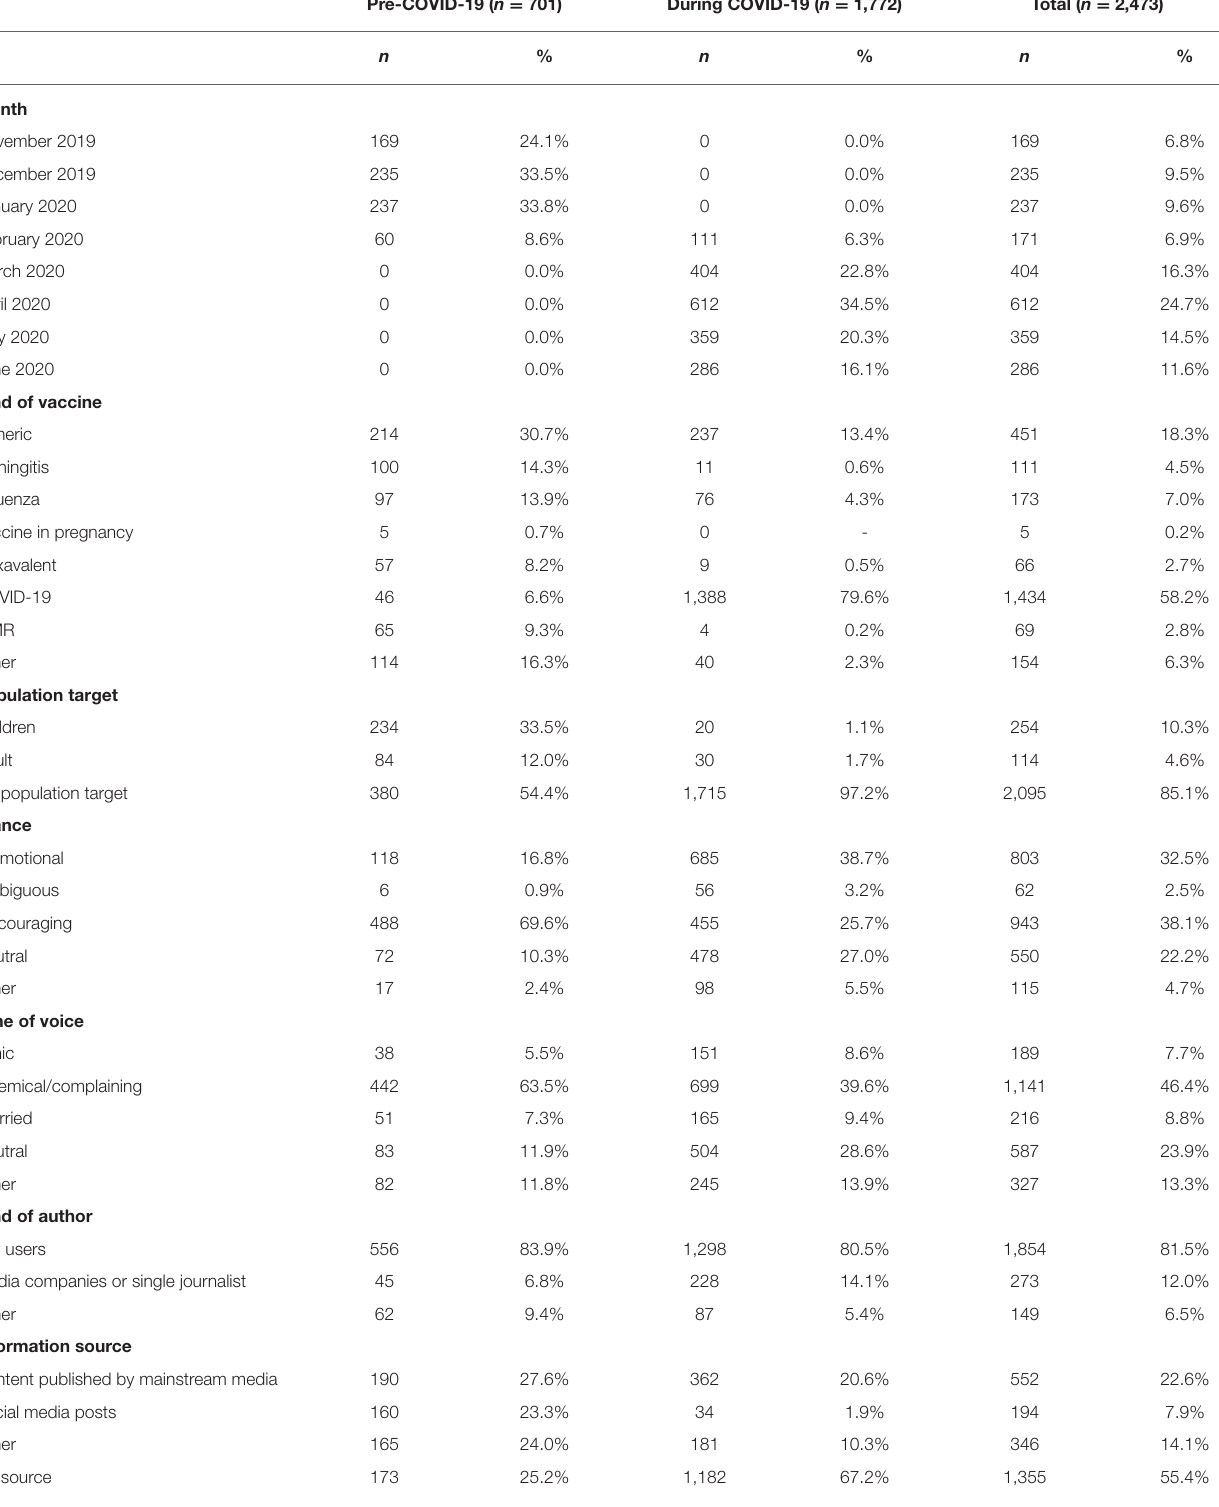
TABLE 2 | Characteristics of tweets by period (before and after 21 February